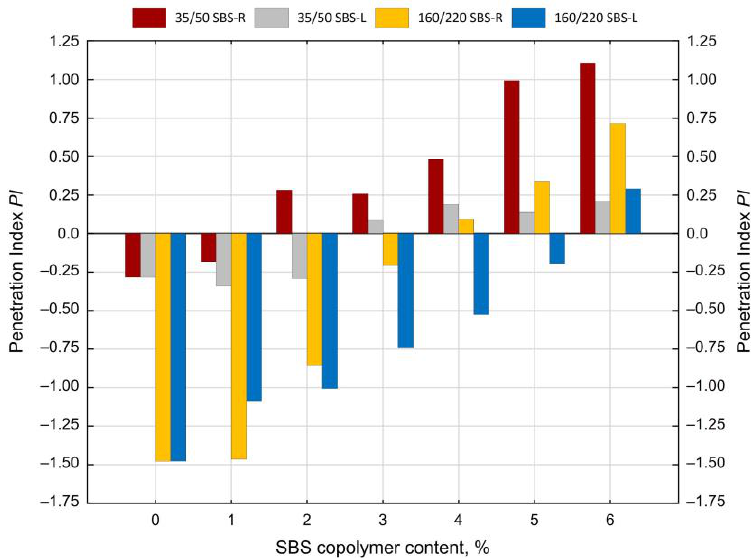
Figure 10. Penetration index of SBS-modified bitumens.